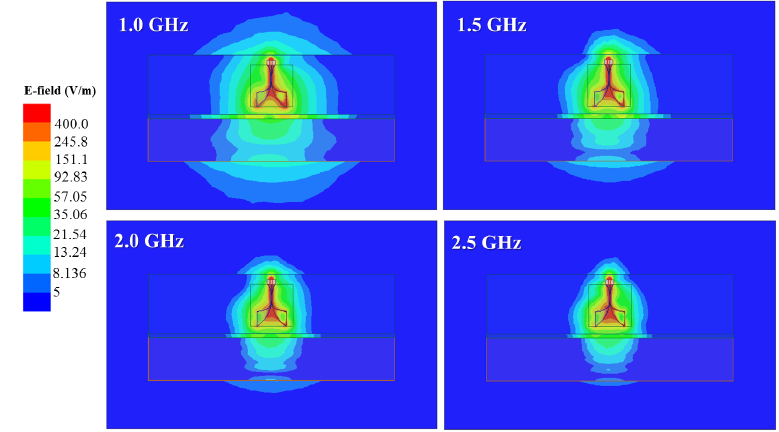
Figure 5. The absolute value of the electric field ( E ) induced by one AVA inside ethanol. The container and compression paddle are accounted for by a simplified model in HFSS. The top and bottom blocks represent the ethanol volume and the compressed breast, respectively. A thin layer of plastic (acrylic, 6 mm) is placed in between the